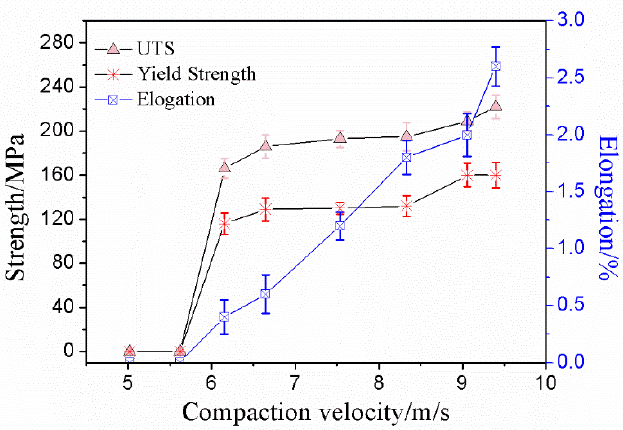
Figure 8. Ultimate tensile strength, yield strength and elongation versus compaction velocity.